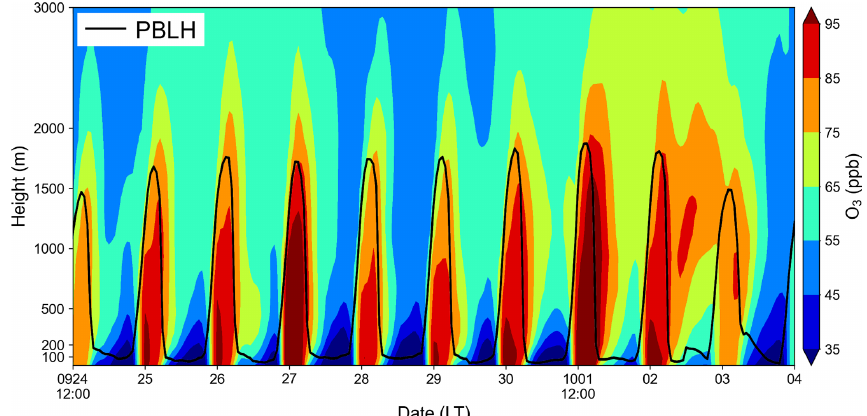
Figure 9. Temporal–vertical distribution of the O 3 concentration above PRD during the O 3 episode. The black line represents the height of the planetary boundary layer (PBLH).